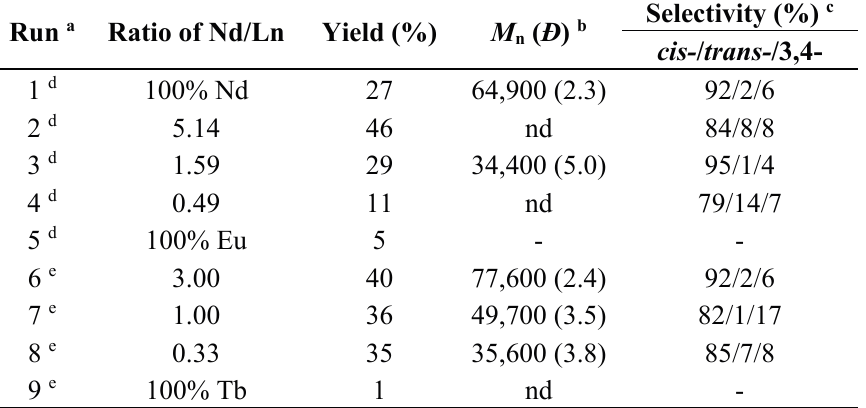
Table 1. Isoprene polymerization using mixed Nd/Ln(form) 3 (Ln = Eu or Tb) as pre-catalysts. Run